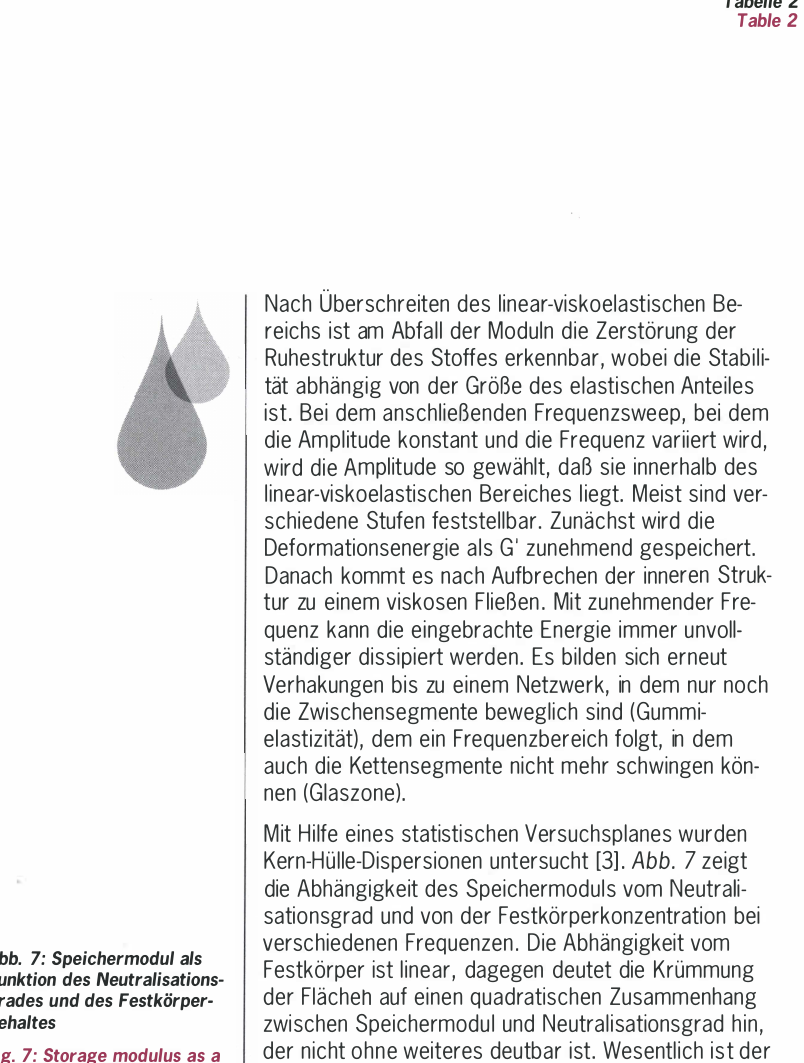
Table 2: Q u a n t i t i e s